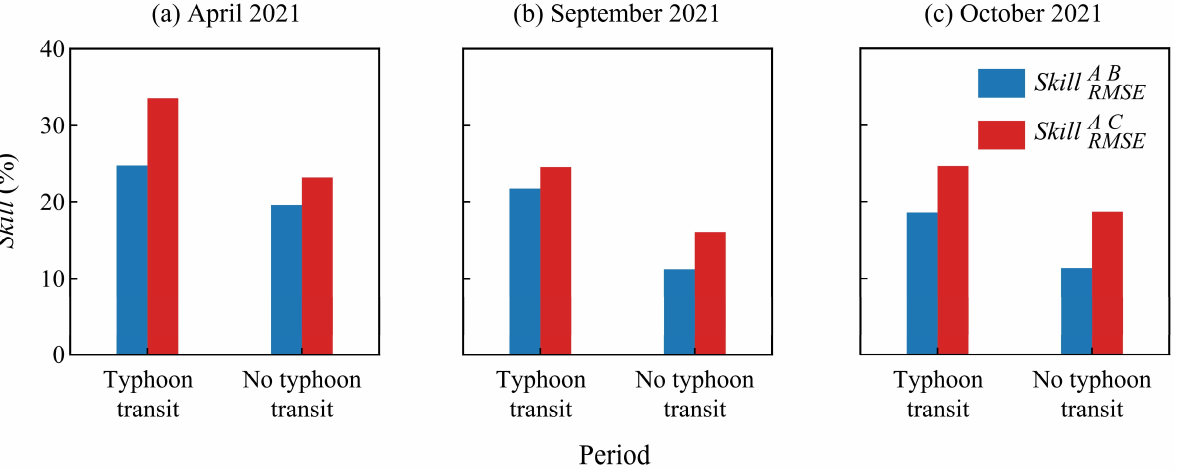
Figure 9. Statistical analysis of Skill RMSEA B , and Skill RMSEA C for typhoon transit or no typhoon transit in April, September, and October 2021. ( a )-( c ) April, September, and October 2021, respectively.